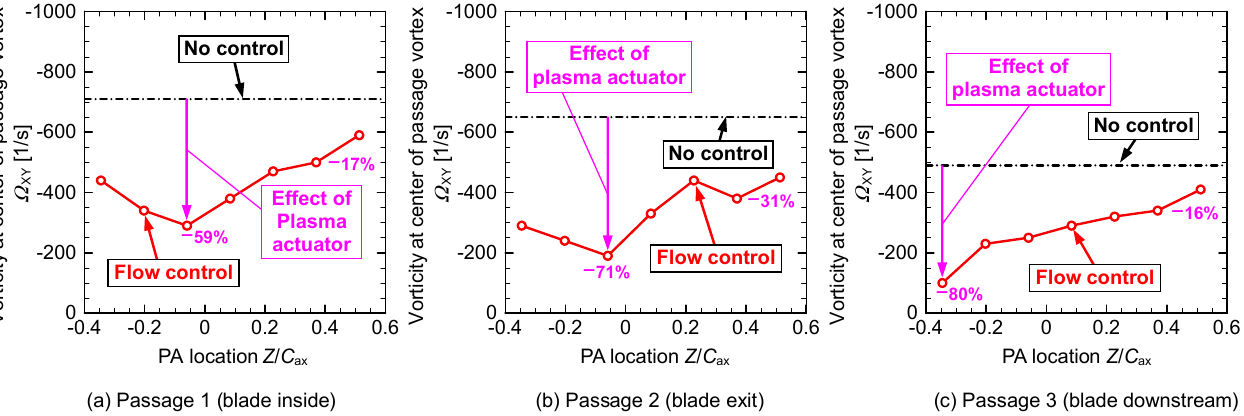
Figure 15. Effect of the plasma actuator location on the vorticity at the center of the passage vortex (Re out = 1.8 × 10 4 ).